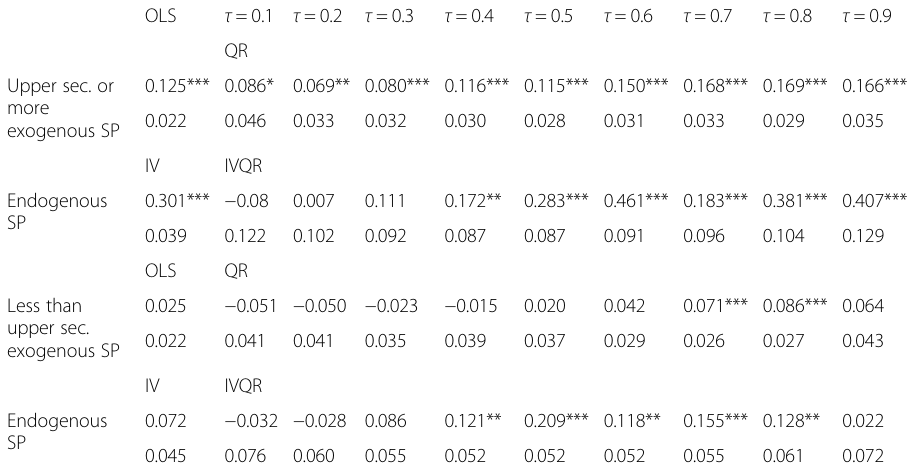
Table 6 Estimates by educational attainment, no occupational controls